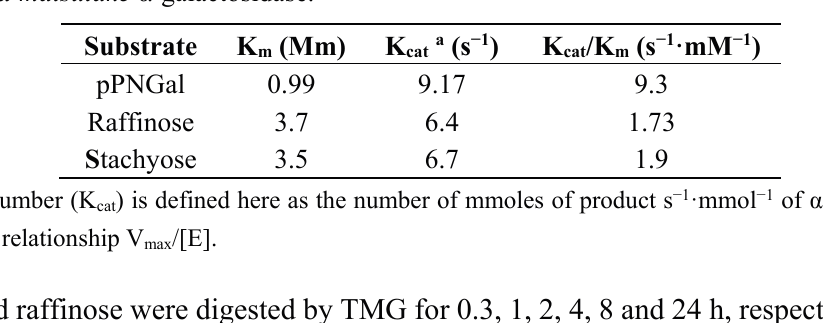
Table 4. Kinetic parameters for hydrolysis of pNPGal, raffinose and stachyose by Tricholoma matsutake α -galactosidase.